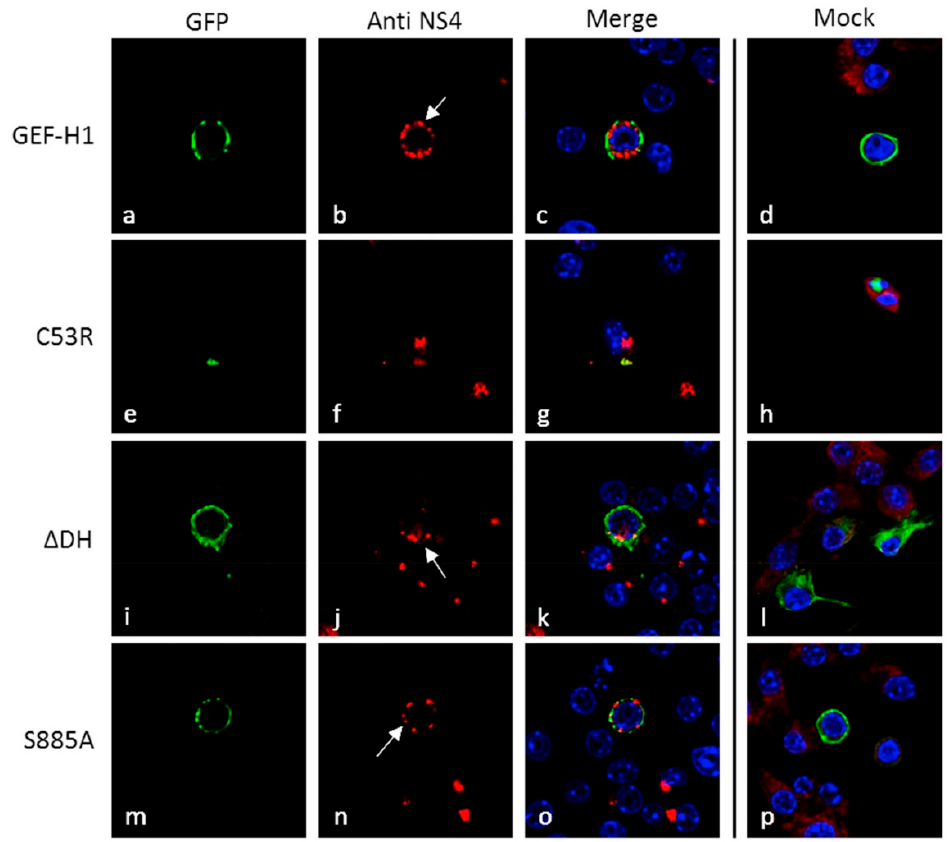
Figure 2. The expression of GEF-H1 WT induces the dispersion of the MNV RC. Murine macrophages (RAW264.7) were transfected with GFP-tagged GEF-H1 forms (WT, C53R: unable to associate with microtubules, ∆ DH: no GEF activity, S885A: constantly active GEF) and at 12 h post-transfection (h.p.t.) were subsequently infected with MNV (MOI 5). Cells were fixed at 12 h.p.i. and immune-labelled with an anti-NS4 antibody for confocal microscopy analysis. The GFP signal of the different GEF-H1 forms is displayed in panels a, e, i, and m (green), while panels b, f, j, and n show the staining with the anti-NS4 antibody (red). Panels c, g, k, and o show the merged image including the nuclear stain (DAPI; blue). Panels d, h, l, and p represent the merged image of the GEF-H1-GFP transfected but uninfected cells. Macrophages expressing the microtubule-associated forms of GEF-H1 (WT, ∆ DH, S885A) all showed a dispersion of the MNV RC (white arrows).